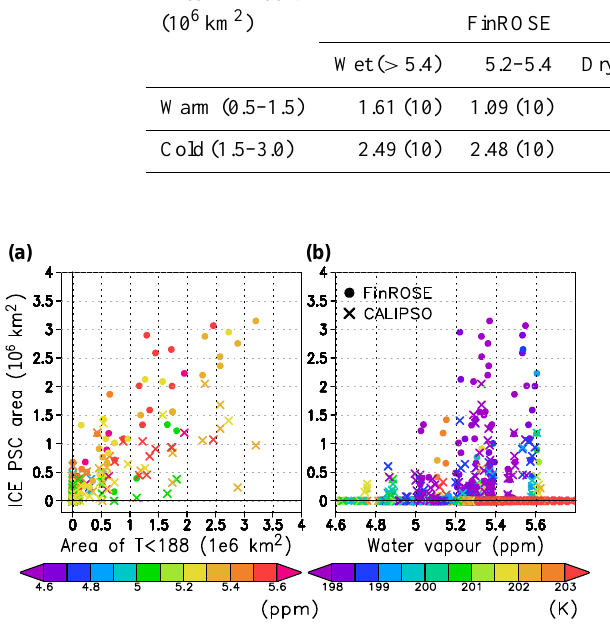
Figure 8. Panel (a) : scatter plot of December–February ice PSC area versus the area colder than 188K in the Northern Hemisphere from FinROSE and CALIPSO at 56hPa. The colour denotes the vortex mean water vapour content (ppm). Panel (b) : scatter plot of the December–February ice PSC area versus the vortex mean wa- ter vapour content (ppm) from FinROSE and CALIPSO at 56hPa. The colour denotes the vortex average temperature (K). FinROSE is shown with dots and CALIPSO is shown with crosses.